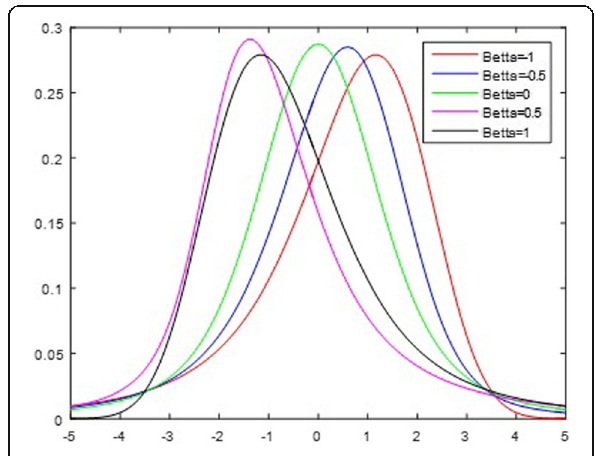
Fig. 3 Alpha-stable distribution for different values of β